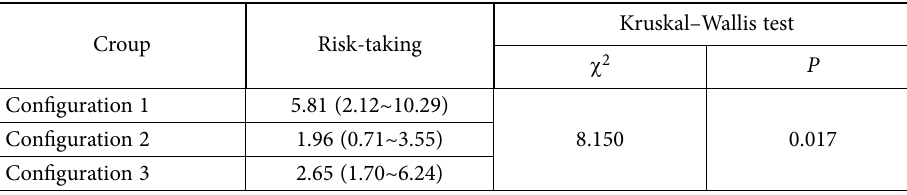
Table 4. Risk-taking nonparametric test